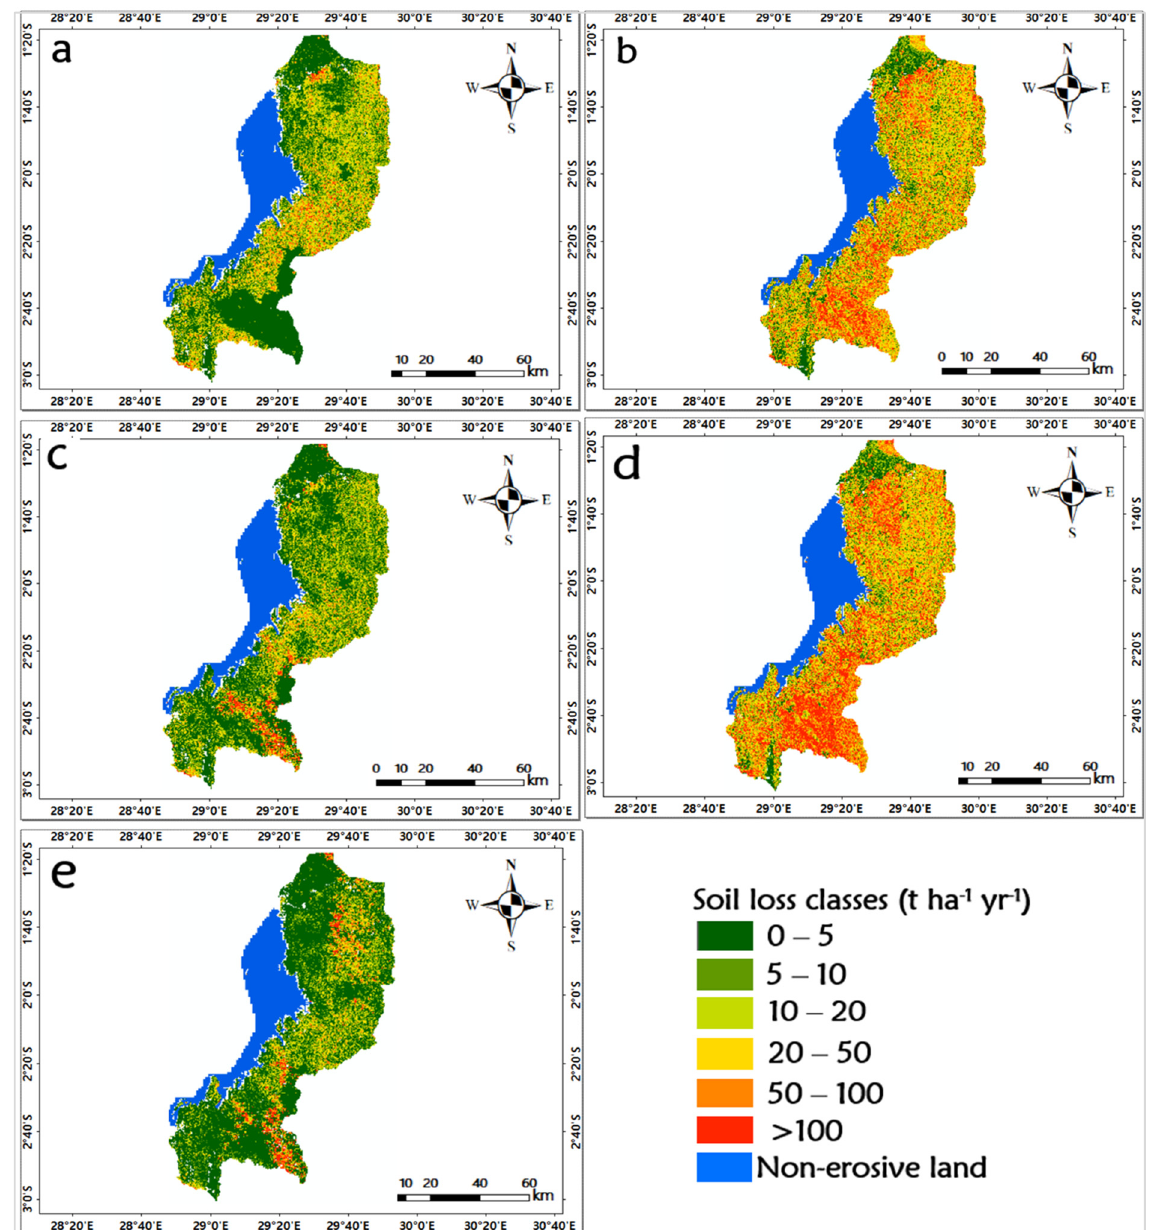
Figure 9. Spatial distribution of estimated soil erosion rates in the study area: ( a ) 2000, ( b ) 2005, ( c ) 2010, ( d ) 2015 and ( e ) 2018.